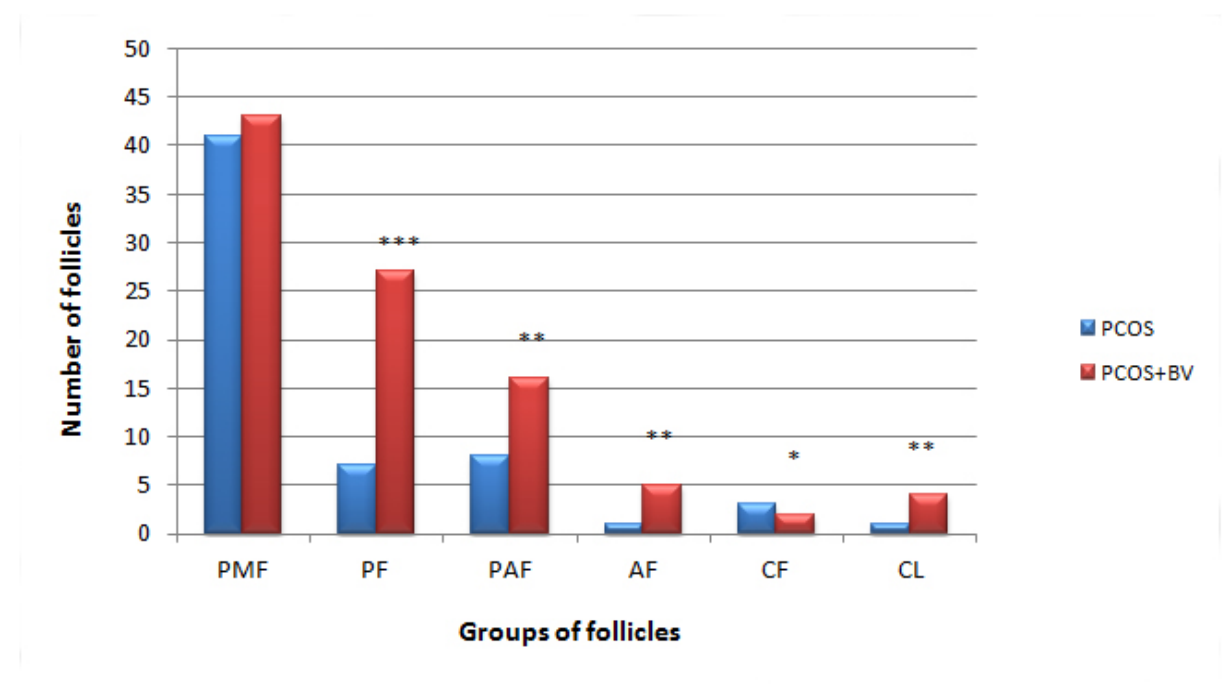
Figure 4. Different follicular types in the ovaries of PCOS and BV-treated PCOS rats. A significant increase in all follicular clusters is detected in BV-treated PCOS ovaries (n = 10), (except primordial follicles). Moreover, a significant decrease in the number of ovarian cysts is also detected. PMF: primordial follicle; PF: primary follicle; PAF: preantral follicle, AF: antral follicle; CF: cystic follicle; CL: corpus luteum; ***p < 0.001; **p <